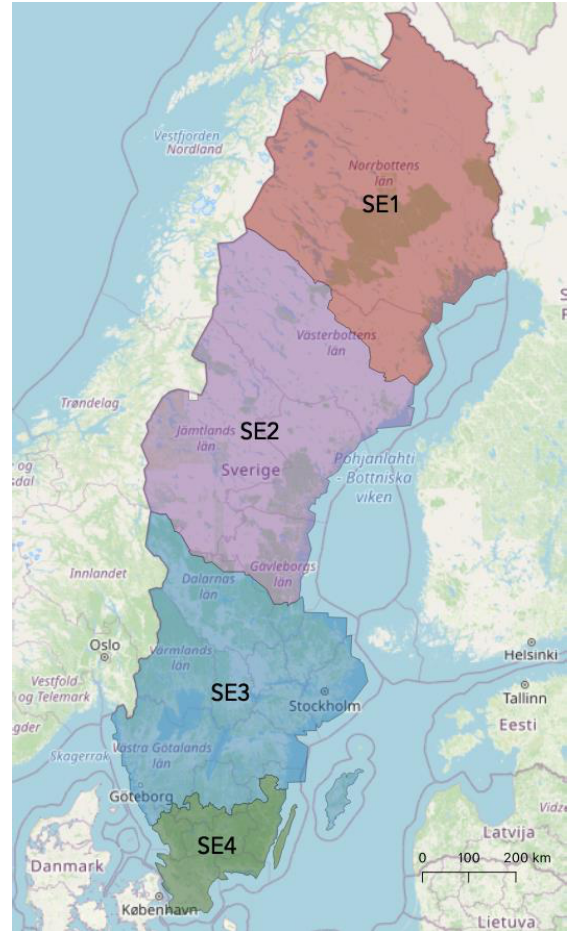
Figure 4. Map of the electricity pricing areas in Sweden. SE1 and SE2 generally have lower electricity prices than SE3 and SE4 [95,96]. Based on the maps of electricity price areas in Vindbrukskollen [107].